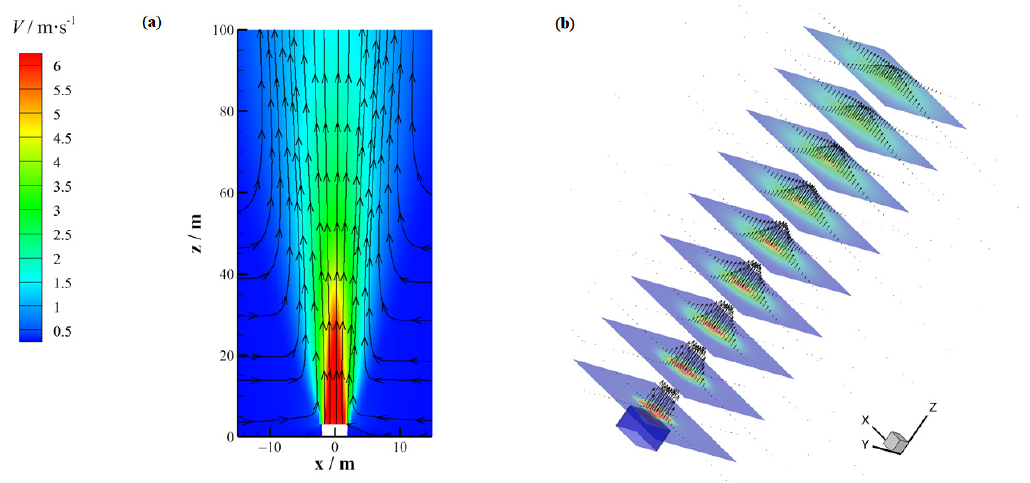
Figure 8. ( a ) Flow structure and ( b ) velocity vector of the vertical outlet when V 0 = 6 m/s without considering the ambient wind.